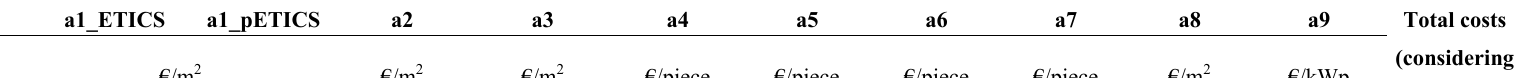
Table 4. Retrofit and maintenance costs that are required in thirty years of the five energy retrofit strategies a1_ETICS: external wall resulted by the field survey as easily ETICSable, a1_pETICS: external wall resulted by the field survey as potentially